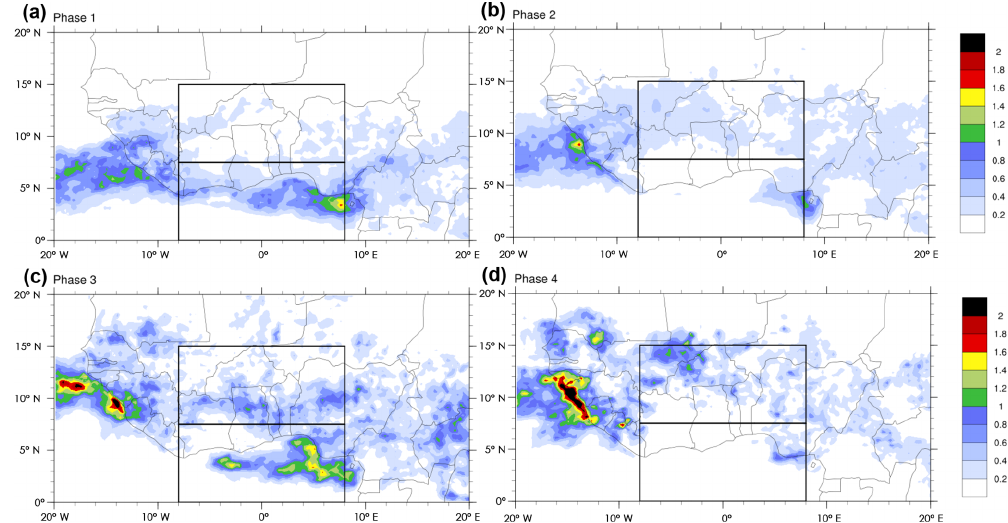
Figure 6. Horizontal distribution of mean precipitation during the four phases of the DACCIWA campaign. Plots are based on TRMM precipitation and given in millimetres per hour. (a) Phase 1 (1–21 June 2016), (b) Phase 2 (22 June–20 July 2016), (c) Phase 3 (21–26 July 2016) and (d) Phase 4 (27–31 July 2016). The black boxes mark the areas used to compute the north–south precipitation difference shown in Fig. 5a. Corresponding anomalies are shown in Fig.